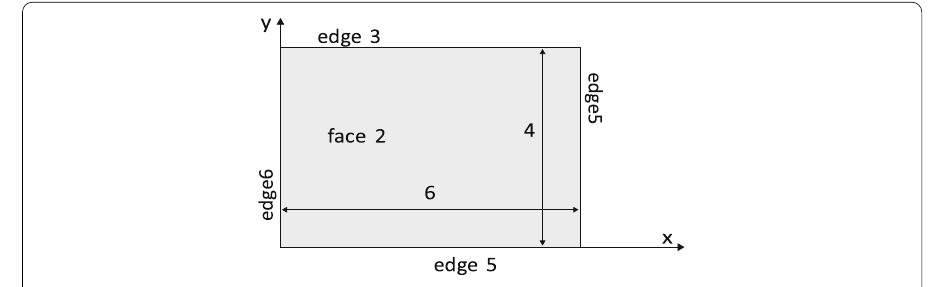
Fig. 17 Example single patch: one surface with the sizes 6 ×